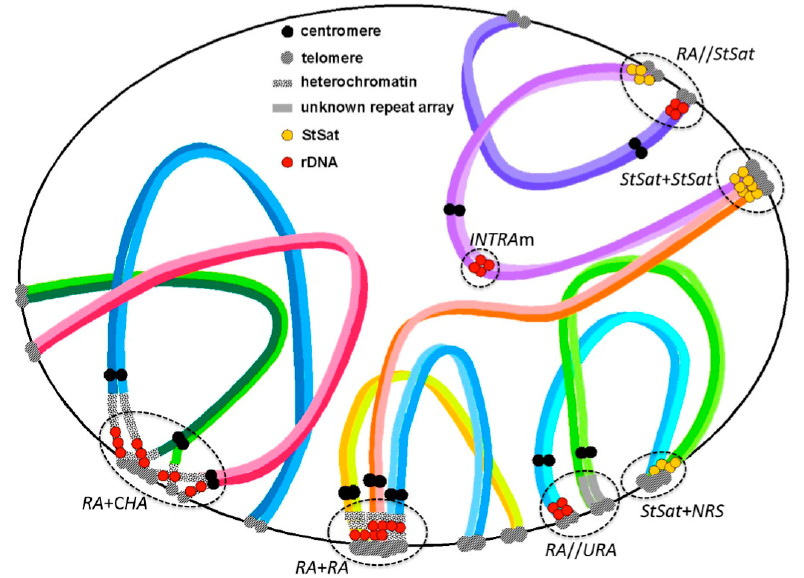
Figure 1. Examples of chromosomal configuration in pachytene stage inferred from observations of somatic and meiotic chromosomes in primates. RA + RA : association among rDNA arrays ( RA ) (observed in chimpanzee). RA + C HA : association between RA and constitutive heterochromatin arrays (C HA ) (observed in slow loris). RA // StSat : non-association between RA and subterminal satellite (StSat) (observed in chimpanzee, bonobo, and gorilla). RA // URA : non-association between RA arrays and unknown repeat arrays ( URA ) (observed in chimpanzee and gorilla). StSat + StSat : association of interchromosomal StSat (observed in chimpanzee). StSat + NRA : association between StSat and non-repeat segments ( NRS ) (observed in chimpanzee). INTRA m: intercalary rDNA arrays ( INTRA ) in metacentric chromosome (m) (observed in Japanese and Rhesus macaques).